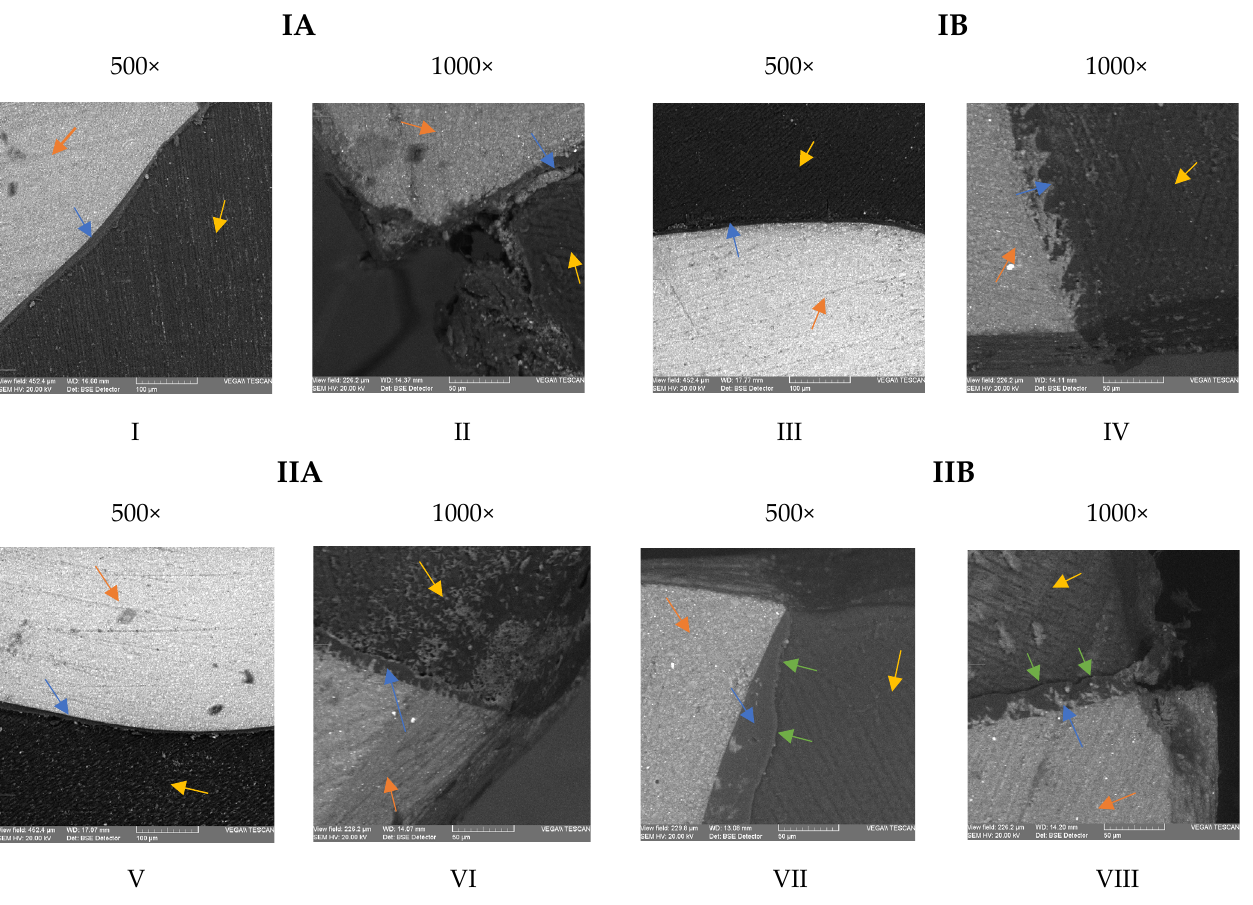
Figure 3. SEM micrographs of the resin–dentin interface after etch-and-rinse technique ( IA ); after etch-and-rinse and 2% chlorhexidine solution application ( IB ); after self-etch technique ( IIA ); after self-etch and 2% chlorhexidine solution application ( IIB ); at 500X and 1000X magnification. * → composite resin; → dentin; → adhesive layer; → marginal defects .